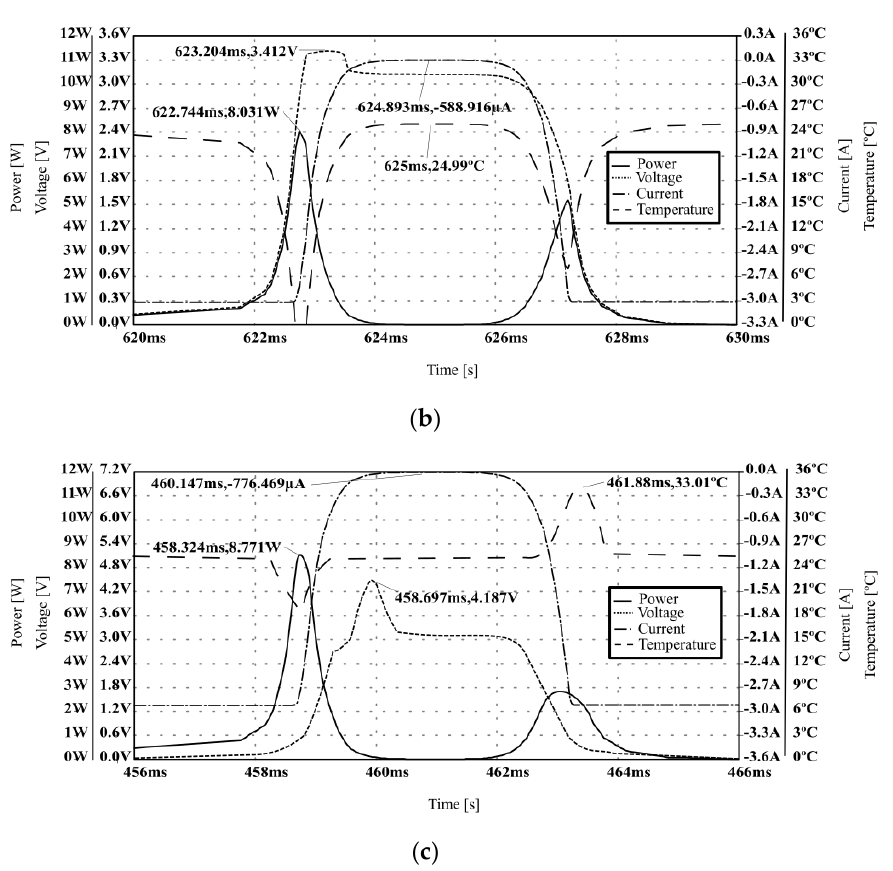
Figure 21. Electrical parameters in elements of a tracer: ( a ) Buck-boost converter; ( b ) Cuk converter; ( c ) SEPIC converter.